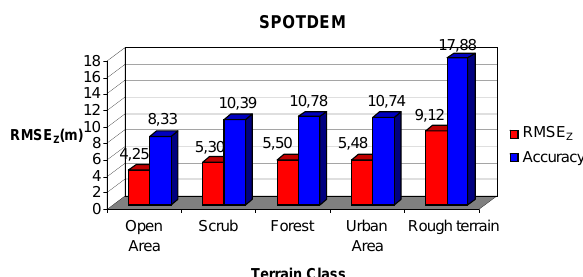
Figure 5. SPOTDEM analyses according to the classes